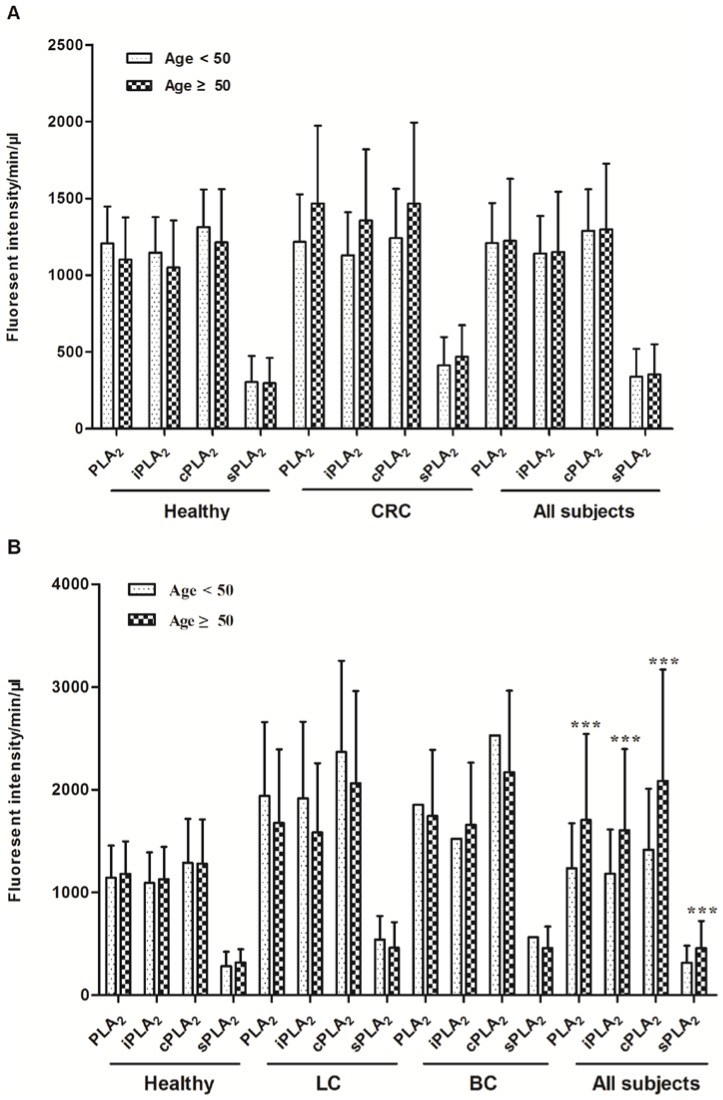
PLA2activities were not significantly correlated to ages.The participants in healthy and CRC groups were divided into two groups: age<50 (For all subjects, n = 42) and age ≥50 (For all subjects, n = 153). Student t-test was performed to analyze the differences between these two groups. A. The participants in healthy and other cancer groups were divided into two groups: age<50 (For all subjects, n = 61) and age ≥50 (For all subjects, n = 144). Student t-test was performed to analyze the differences between these two groups. ***P<0.001.